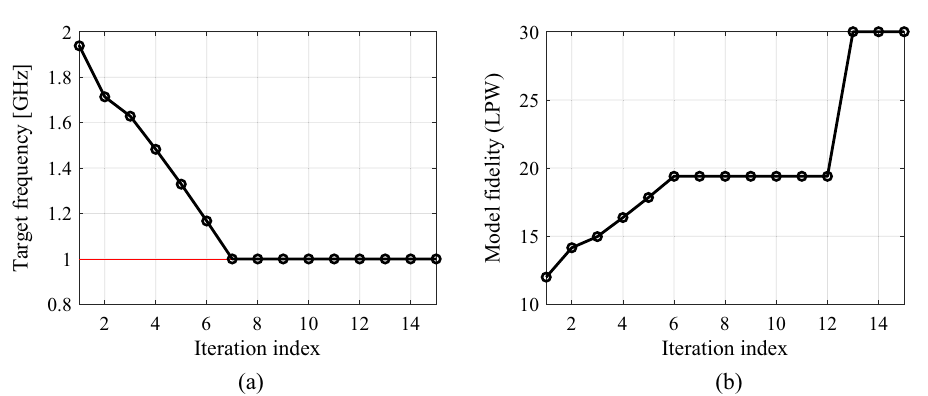
Figure 8. Compact branch-line coupler: ( a ) history of the target operating frequency (horizontal line marks the initial target); ( b ) evolution of the model